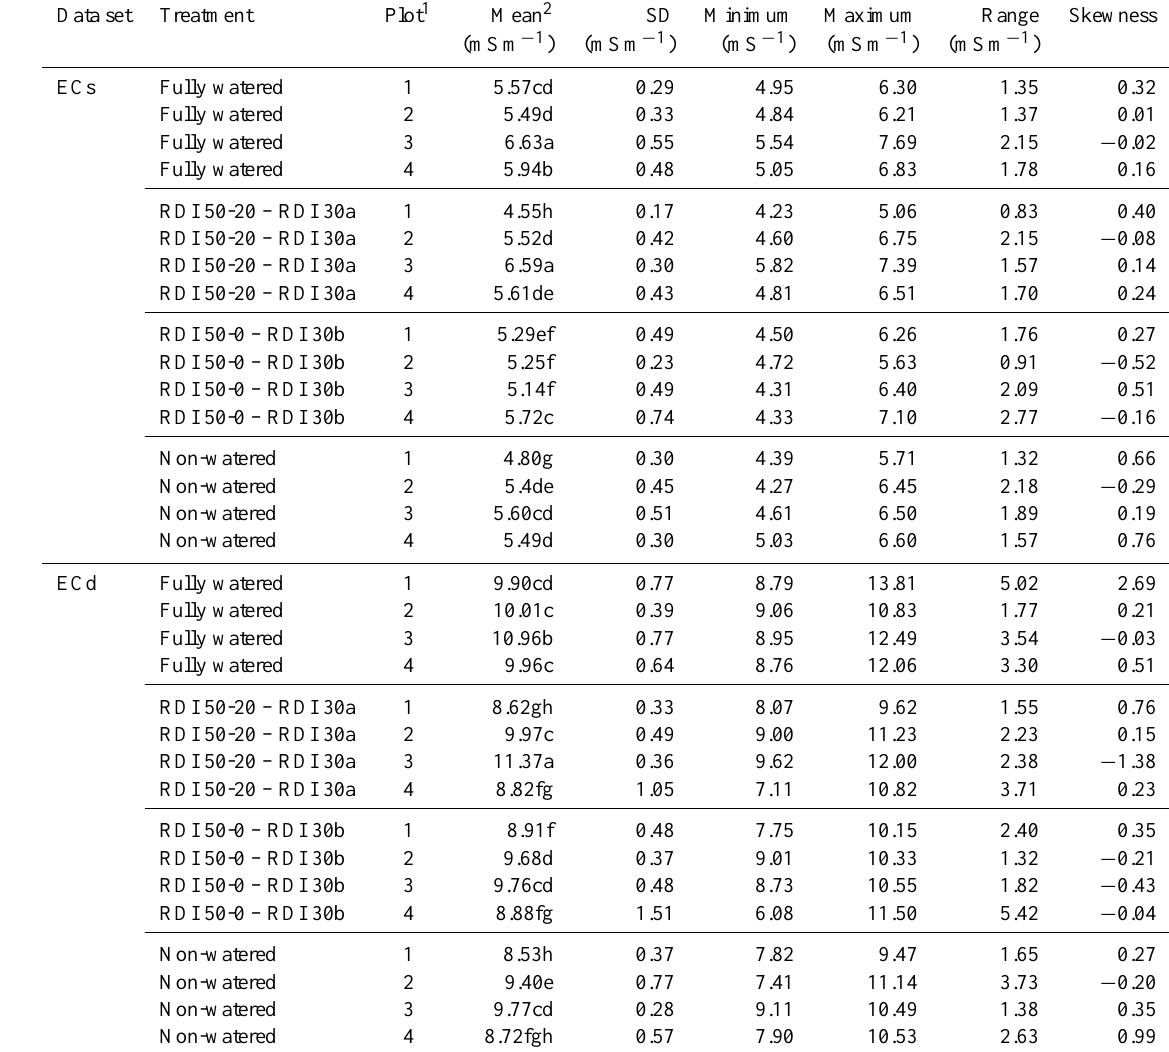
Table 5. Statistic descriptive analyses of shallow and deep soil ECa interpolated data. Data